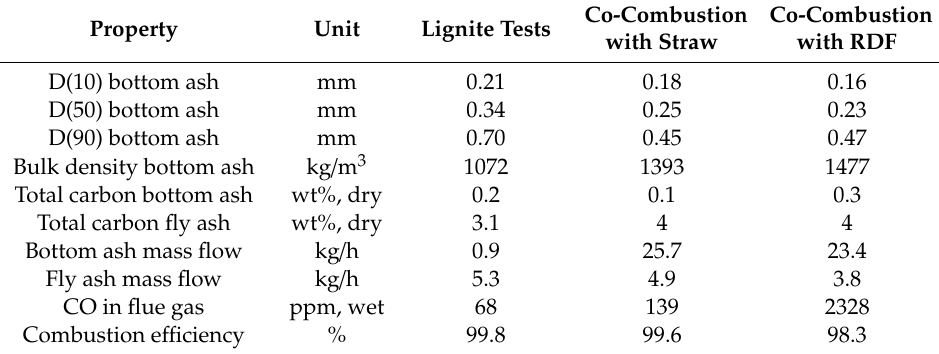
Table 7. Properties of the ash samples and combustion e ffi ciency (long-term steady-state tests).